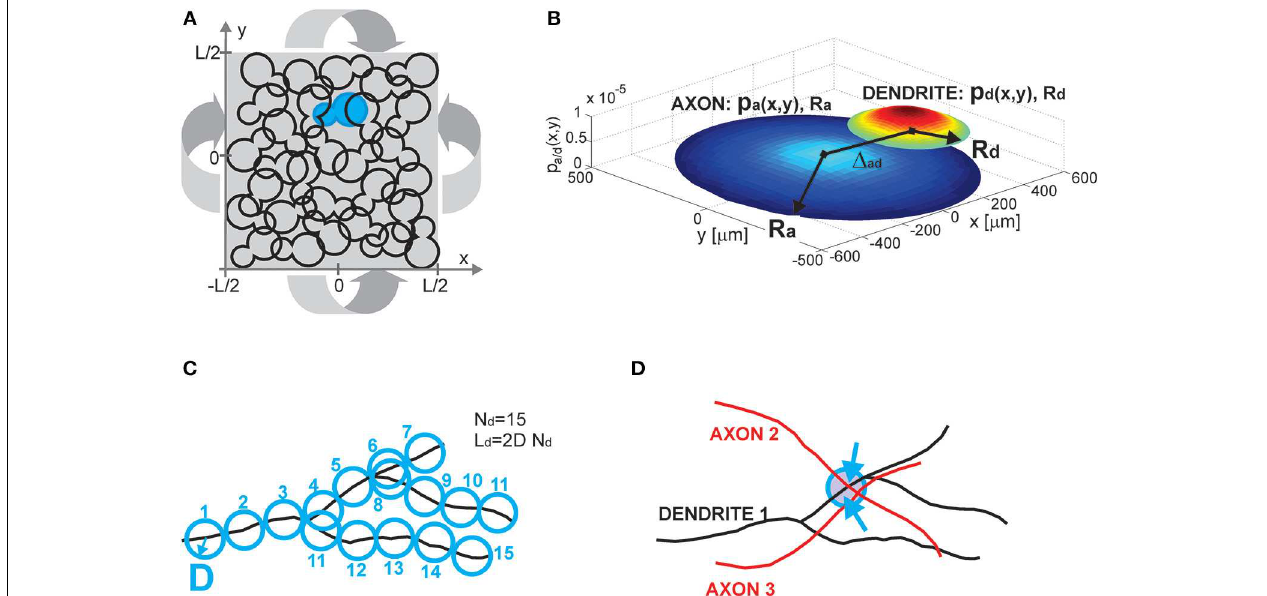
FIGURE 1 | (A) Population of neurons. Each neuron is illustrated as an coordinates ( x , y ) . (C) Neurite segments and density fields . Each neurite 8-shaped surface (to make it more visible, one such surface is colored is divided into segments of length 2 D , and a circle of radius D can be blue). The population of neurons is homogenous, all of the neurons have circumscribed around the middle of the segment. For a dendrite with N d identical properties and they are randomly oriented. The population lays in segments, the total dendrite length is L d 2 DN d . Neurite distribution = the planar space of the size L describes the probability of finding individual segments within the neurite L . The dimension L is chosen to be much × bigger than the size of the neurons. To avoid boundary conditions, the support. It is derived by superimposing many neurites of the same type. (D) plane is projected on a torus (indicated by four arrows). (B) Neuron and Potential synapse formation rule . An axon-dendrite pair can form a neurite models . The axon (a) and dendrite (d) are modeled as density synapse if an axon segment crosses the near neighborhood of a dendrite distributions p a / d ( x , y ) on a limited circular support with radii R a / d . The axon segment, the near neighborhood is a circle of radius D circumscribed and dendrite centers are at a distance 1 ad . The example in (B) shows the around the dendrite segment (blue circle in the figure). The dendrite neurites modeled as truncated Gaussians with the parameters: (axon) segment can form at most one synapse with the considered axon, but it can at the same time form a synapse with every other axon that crosses its R a 500 µ m , σ a 0 . 9 R a , (dendrite) R d 200 µ m , σ d 0 . 7 R d , and the = = = = distance between neurite centers 1 ad near neighborhood (a dendrite segment with two synapses shown in the 400 µ m . The x and y axes are in = figure, the two arrows indicate synapse [ µ m ] , the z axis shows the value of density distribution for the given